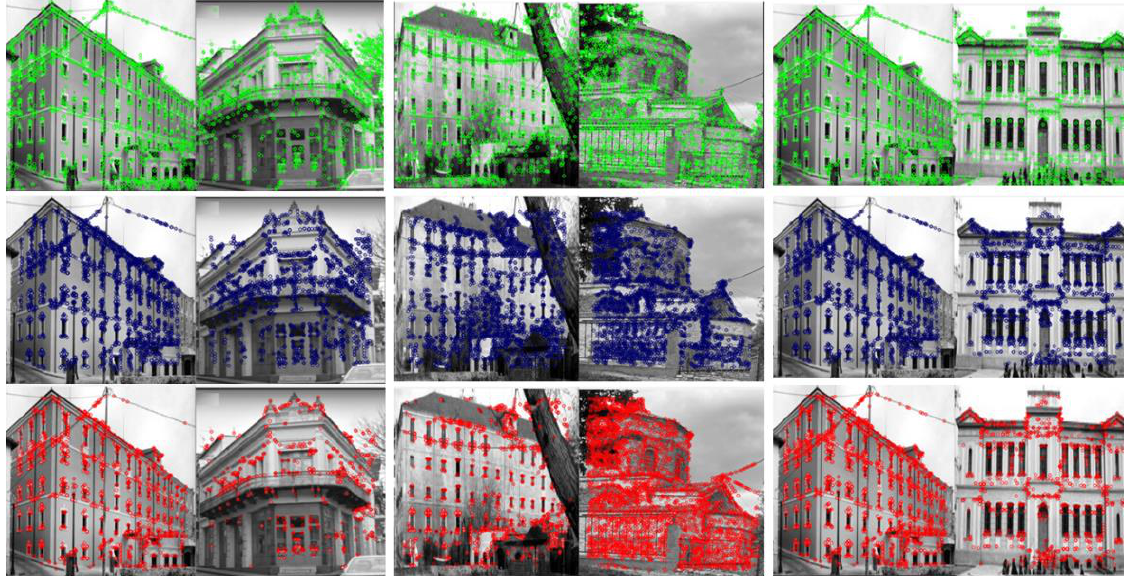
Figure 13. Keypoints detected by SIFT (green), ORB (blue), and BRISK (red) algorithms between different buildings. The first column includes two modern buildings. The second column includes two stone buildings, and the third column includes two buildings of the same order and at the same time; one is historical and the other modern.